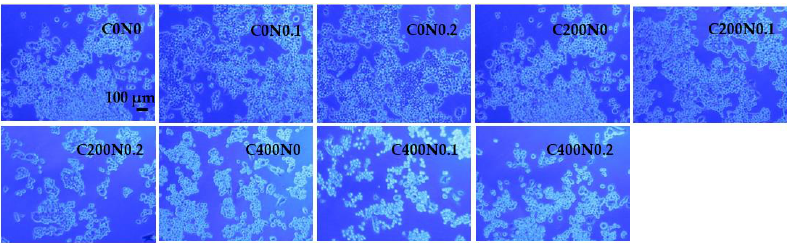
Figure 4. Representative microphotographs of DAPI- staining. RAW264.7 cells were cultured hydrogel materials for 24 h followed by visualization of DNA staining with DAPI using a fluorescence microscope. The data shown are representative of two individual experiments.